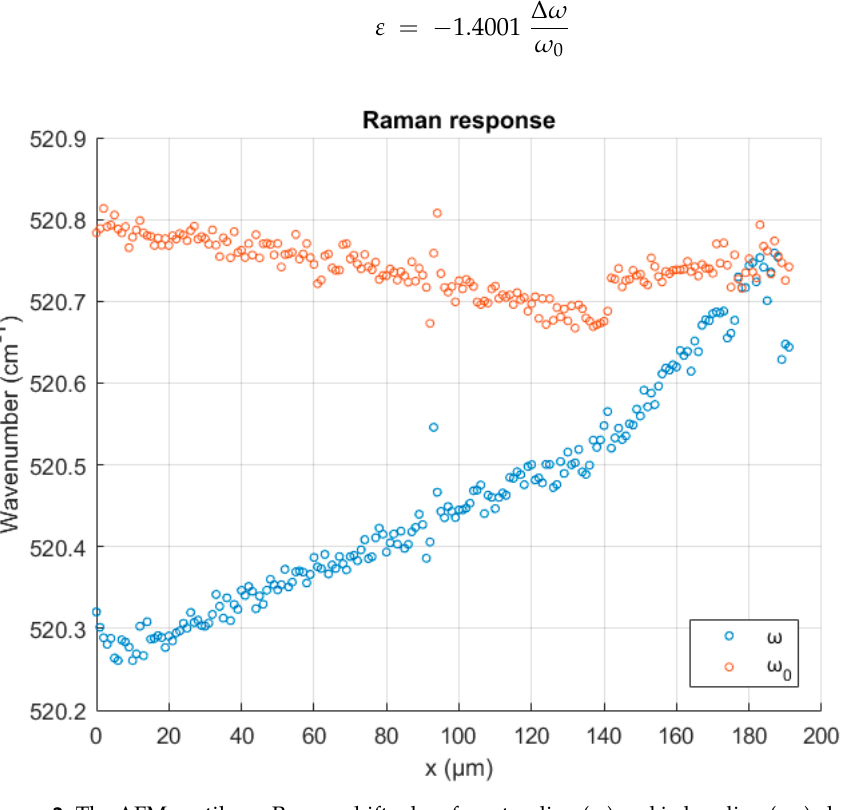
Figure 2. The AFM cantilever Raman shift when free standing ( ω ) and in bending ( ω 0 ) along its x ‐ axis.